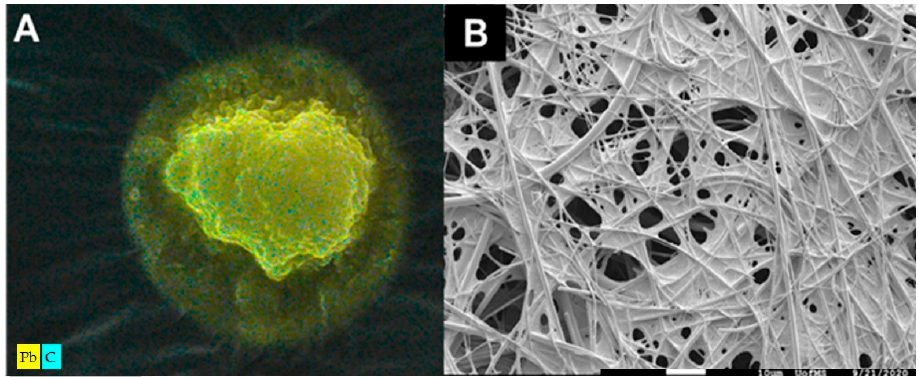
Figure 2. Representative FE-SEM/EDS images of DST and Filters. A representative image of a particle for the DST collection ( A ) is displayed with elemental overlay for Pb (yellow) and C (blue) after a single shot at 6500×; the scale bar indicates 5 µm. No particles were identified on the filter samples ( B ) which provided a complex matrix for imaging at 1000×; the white scale bar indicates 10 µm.